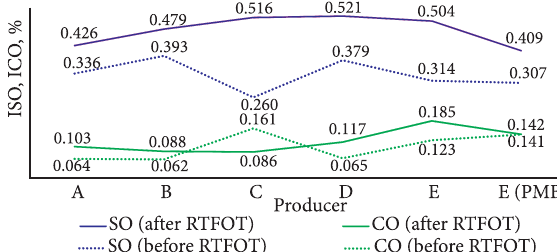
fig. 5. Oxidation of thioether to the sulfoxide during a short- term aging